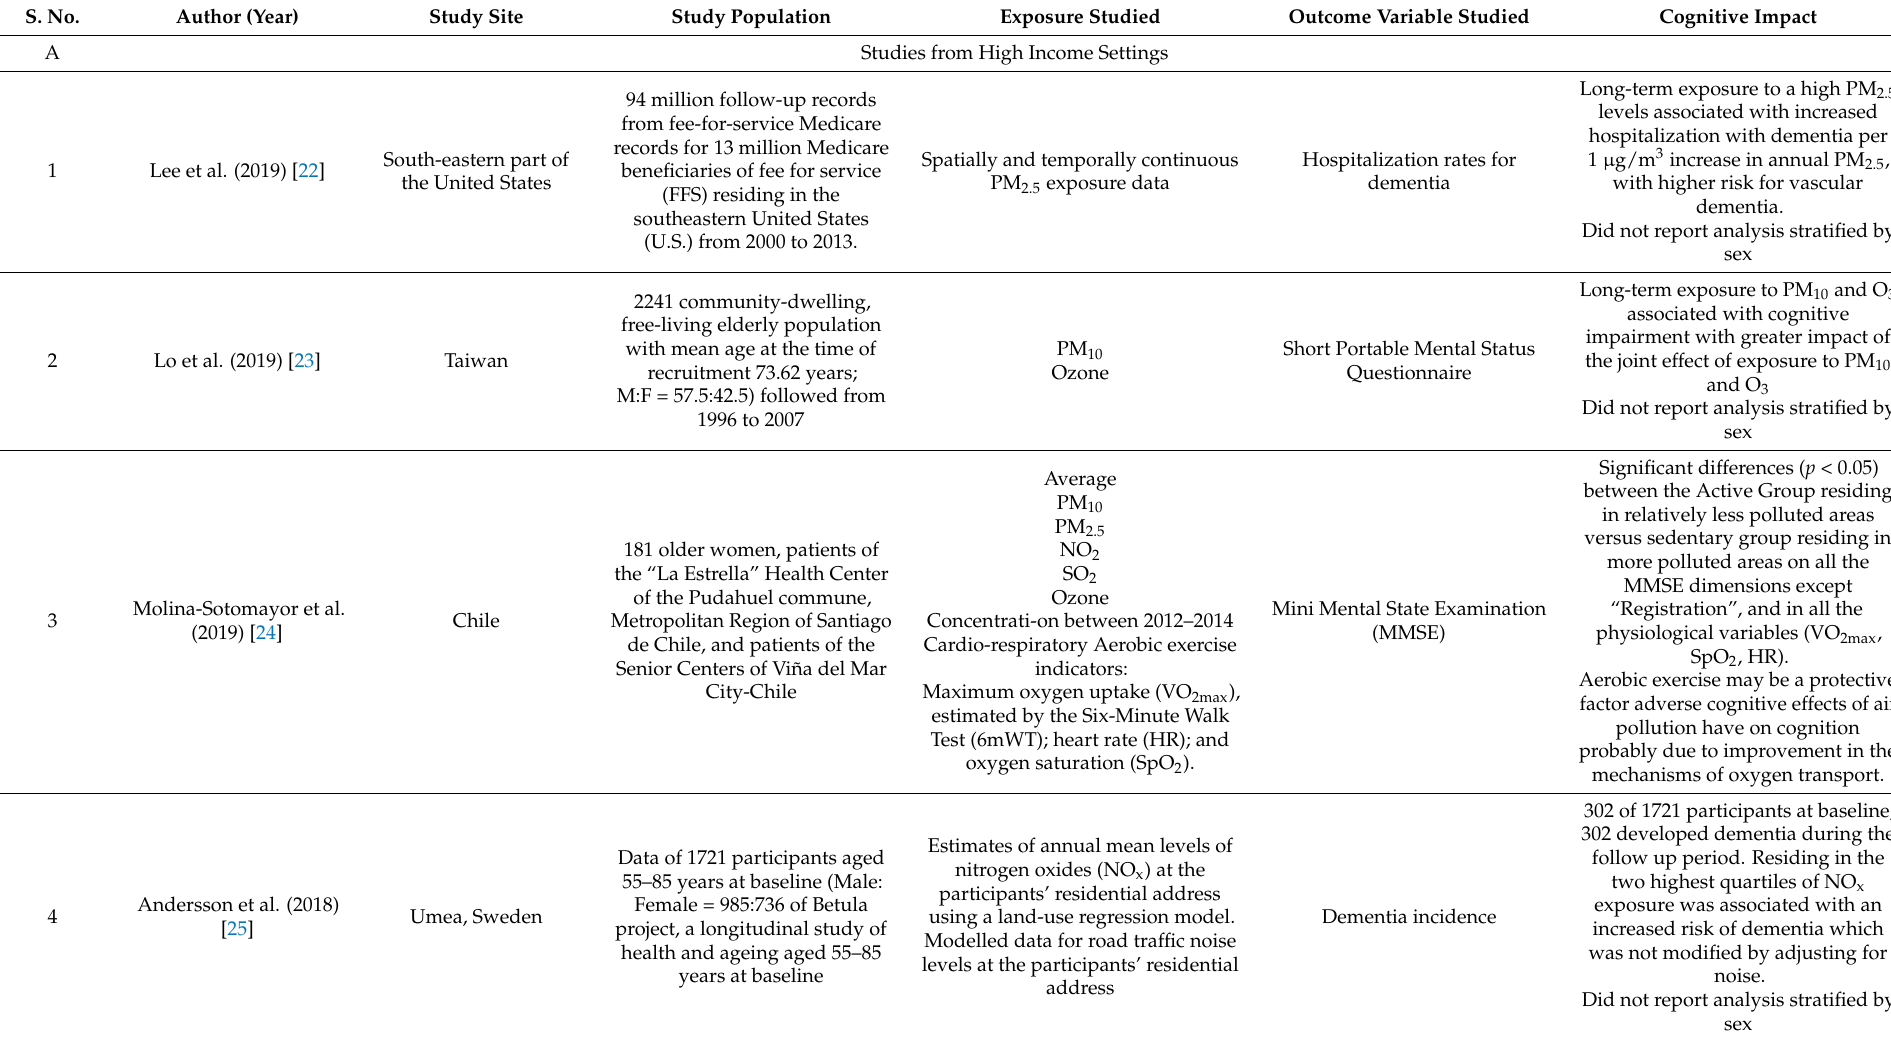
Table 3. Summary of original research on cognitive impact of air pollution across life